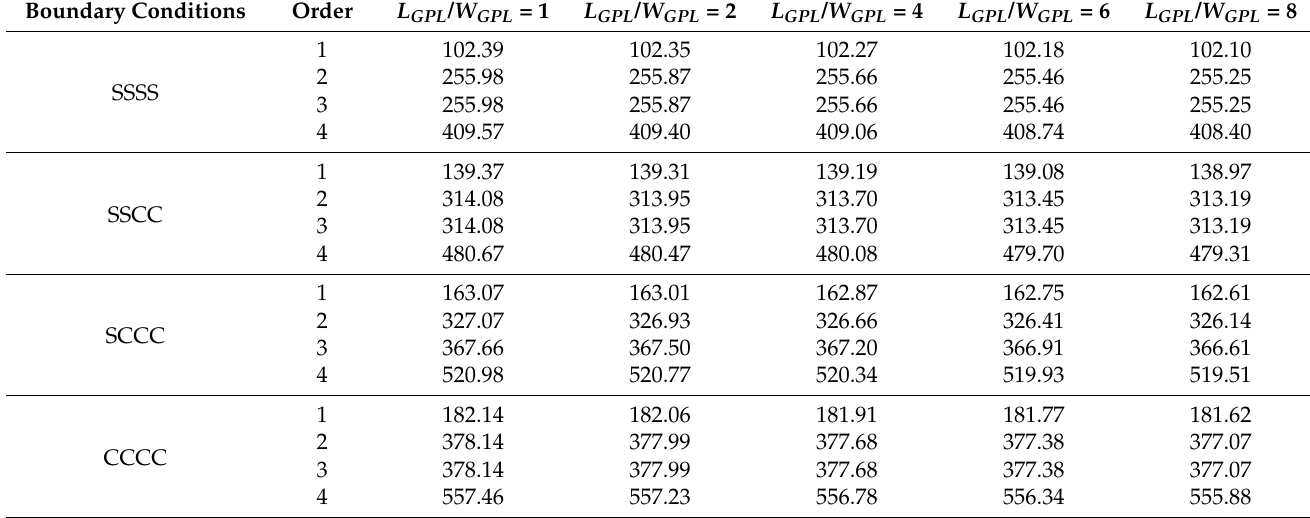
Table A4. Free vibration frequency ω (rad/s) of GPL reinforced porous composite plates with different L GPL / W GPL ratios. Boundary